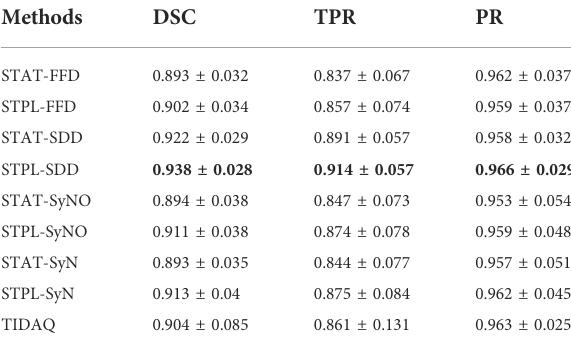
TABLE 7 66% Muscle Segmentation Performance (mean ± standard deviation). DSC: Dice Similarity Coef fi cient, TPR: True Positive Rate, PR: